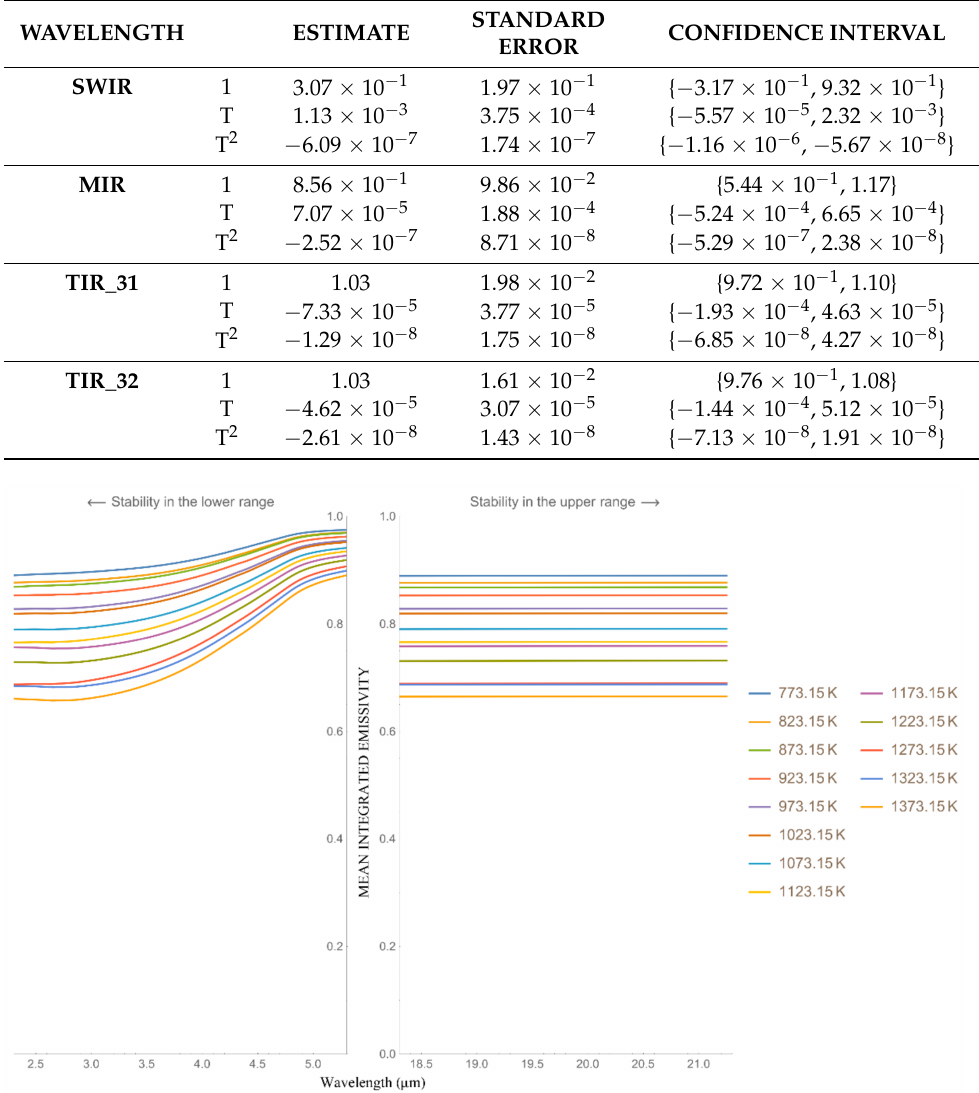
Figure 6. Behaviour of the upper and lower mean emissivity functions ε T , − ( λ ) , ε T , + ( λ ) as their range approaches the full available spectrum. The flattening of the curves indicates that the mean emissivity stabilises enough to allow us to approximate the full spectrum mean emissivity with the limiting value for each given